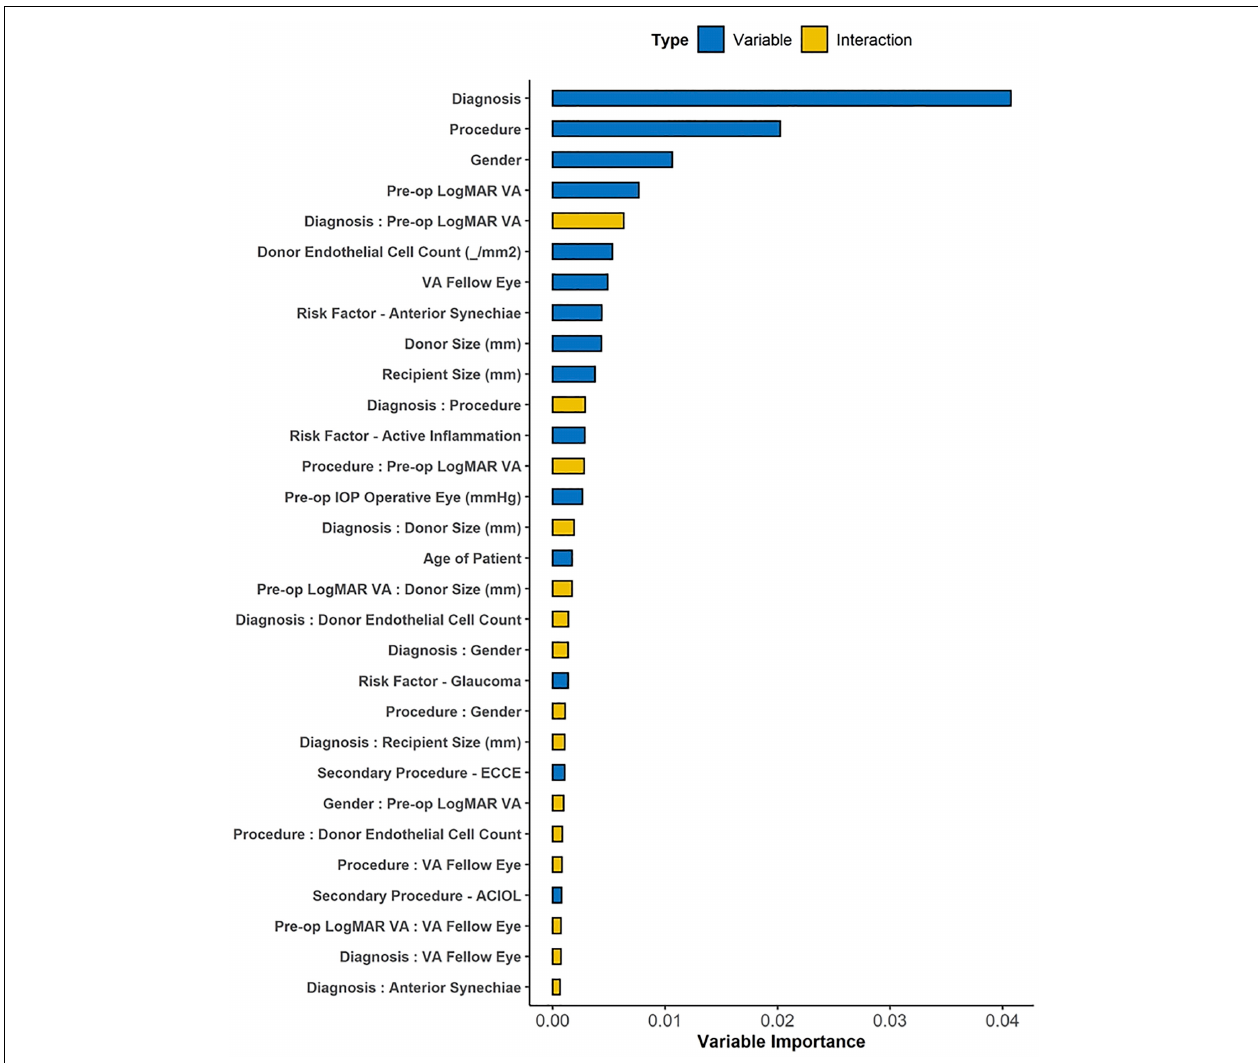
FIGURE 3 | The variable importance (VIMP) plot showing the top 30 variables and interactions for predicting graft failure using Random Survival Forest (RSF) machine learning algorithm. The VIMP score for each candidate variable calculates the difference between the original OOB error rate and the rate after permuting variable values, while VIMP for pair-wise interaction measures the difference between the sum of paired VIMP scores and the VIMP permuting two variables simultaneously. Top-ranked interactions highlight the association between variable pairs that is important for successful prediction in the